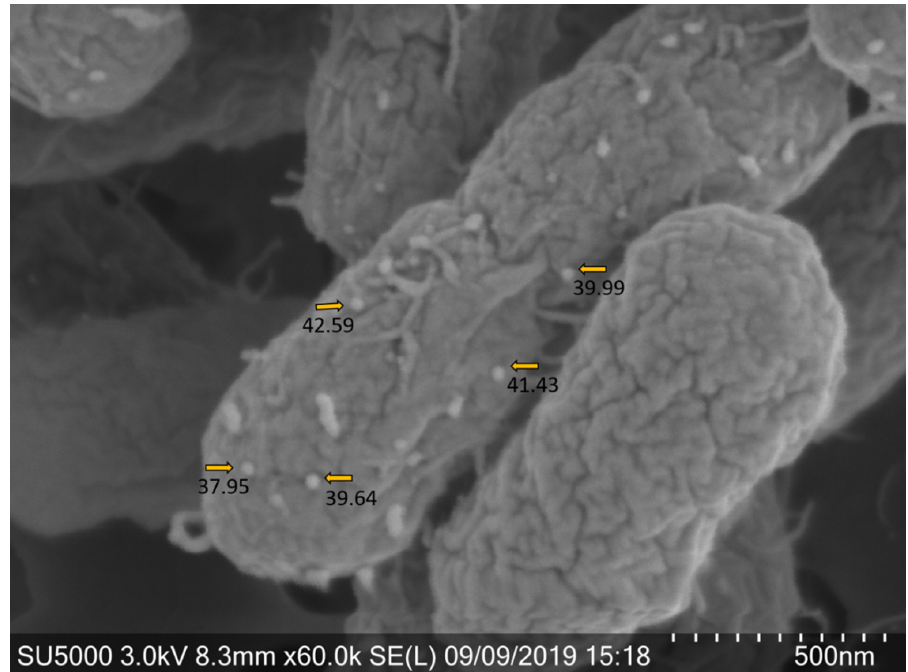
Figure 1. Murine norovirus (MNV) attach to various regions of the outer membrane of Enterobacter cloacae . Scanning Electron Microscopy (SEM) image of E. cloacae after attachment assay with MNV shows virus particles bound on the surface of the bacteria (representative image of n = 2 experiments). Arrows denote viral particles bound to the surface of bacteria as determined by particle size (in nm), which was calculated using ImageJ software.